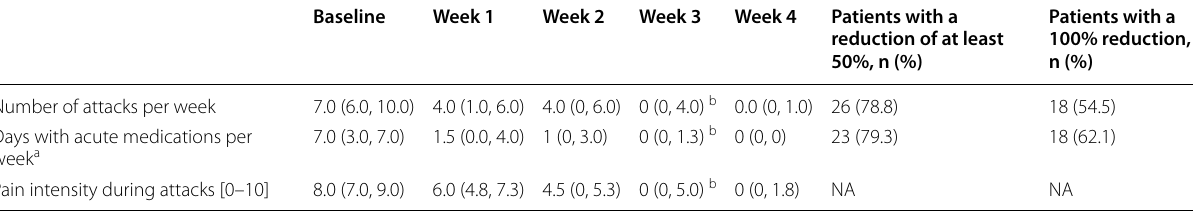
Table 2 Efficacy of 240 mg of galcanezumab therapy at week 3 compared to baseline in patients with episodic cluster headache based on the headache diary ( n 33) =